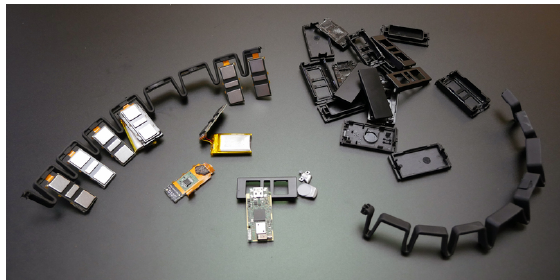
Figure 2. Myo armband tear-down [46].